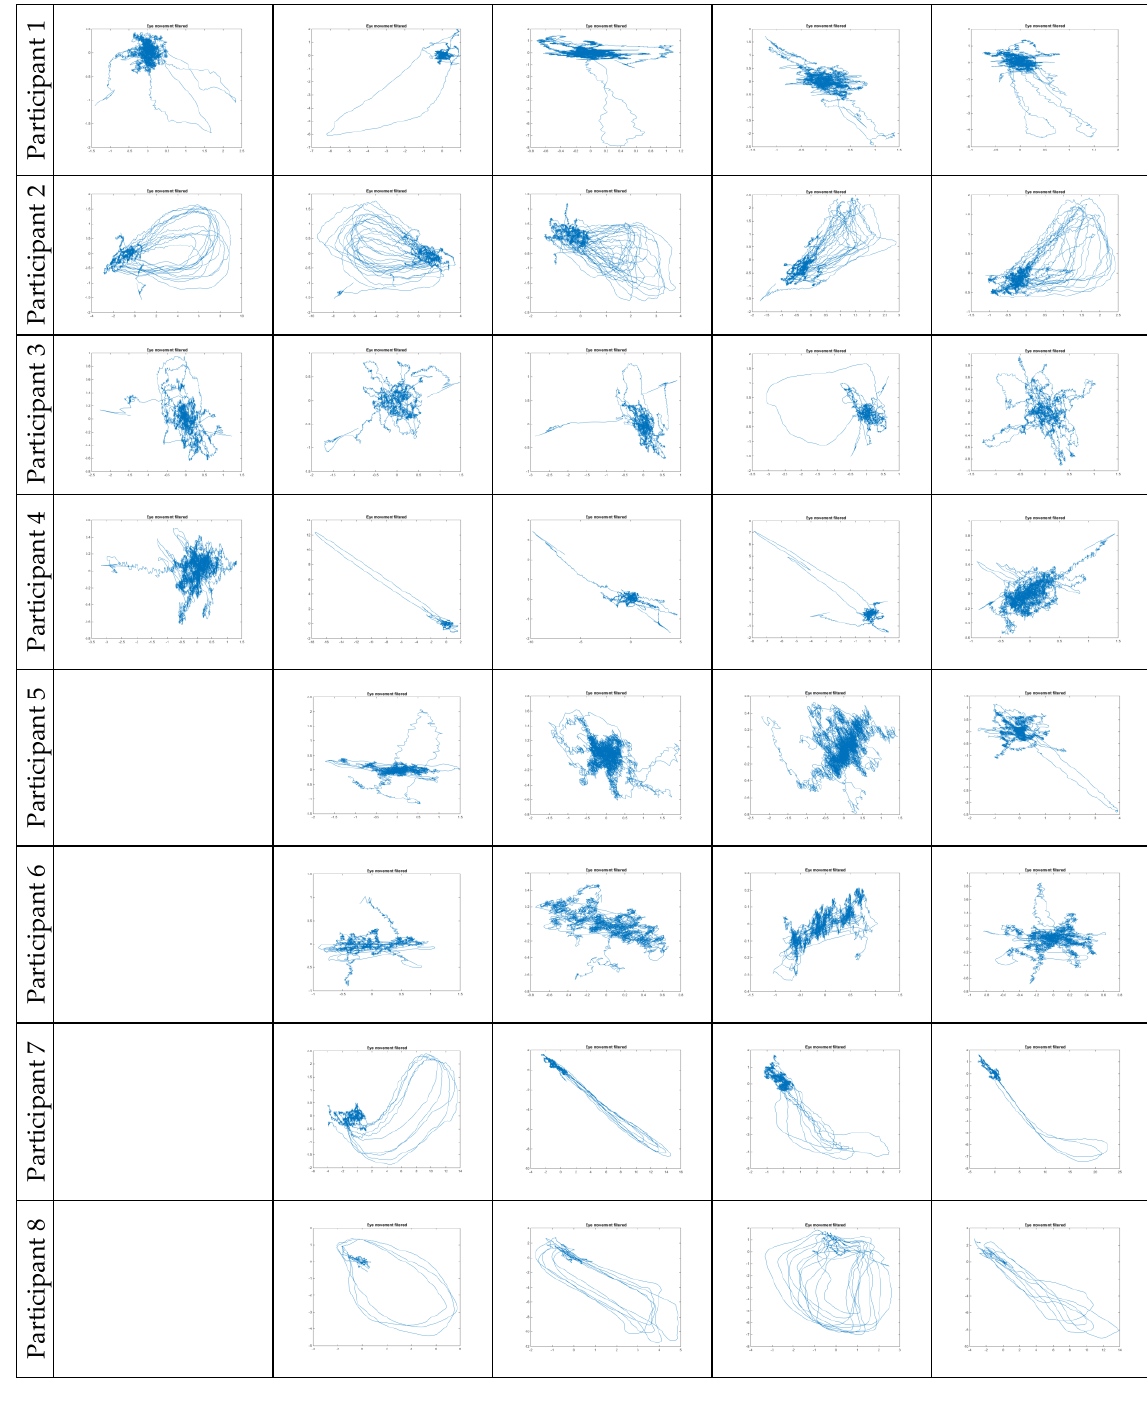
Figure 2. The fixative eye movements for left, right, top, bottom and center points, respectively, for each of the participants.